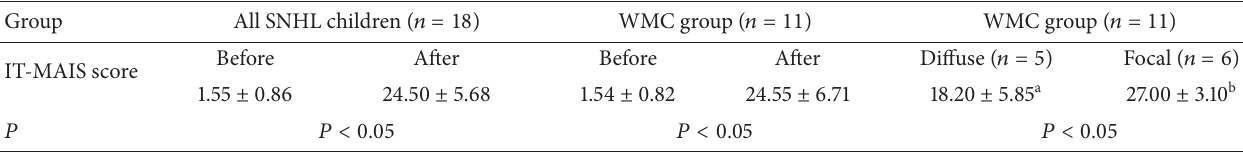
Table 2: IT-MAIS score of children with SNHL before and after cochlear implantation. Group Before After